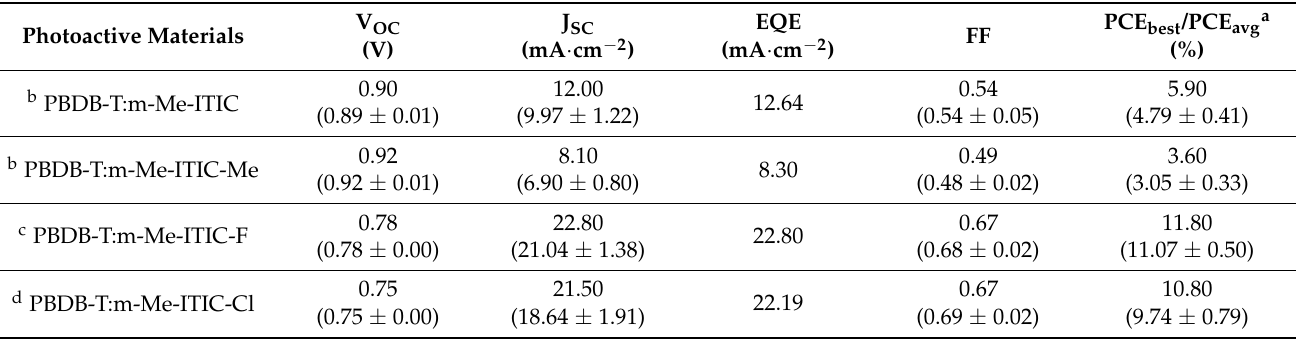
Table 2. The optimized photovoltaic performances of the OPV cells under simulated illumination of AM 1.5 G (100 mW · cm − 2